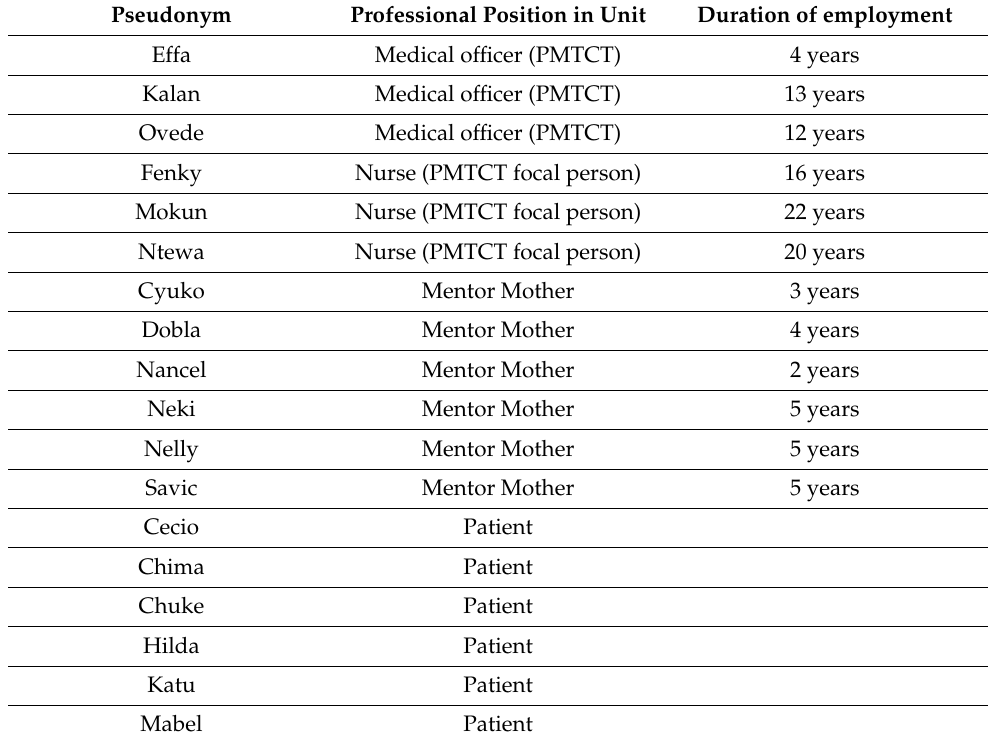
Table 1. Participants